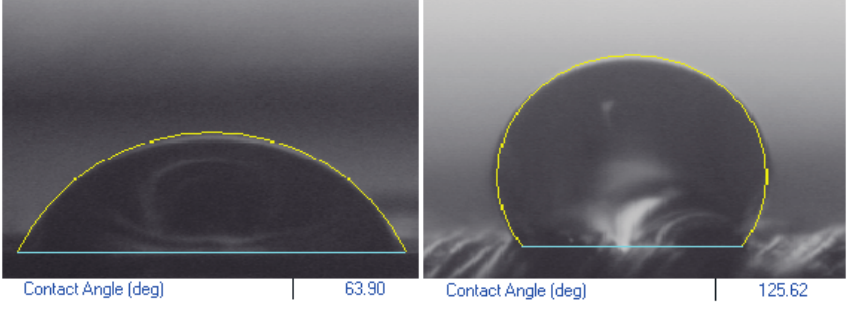
Figure 1. Contact angle measurements, before ( left ) and after ( right ) charring of the hay